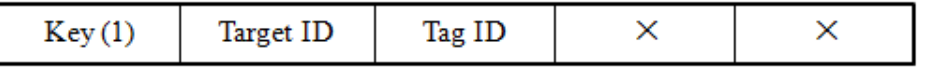
Figure 5. RFID tag’s inquiry signal format for counting outside